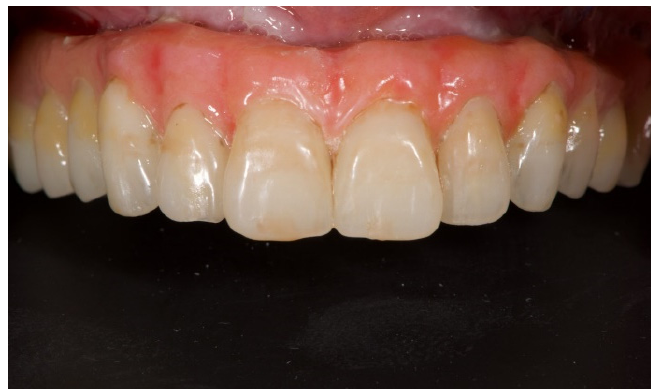
restoration to stop at the correct vertical dimension of occlusion and centric relation.